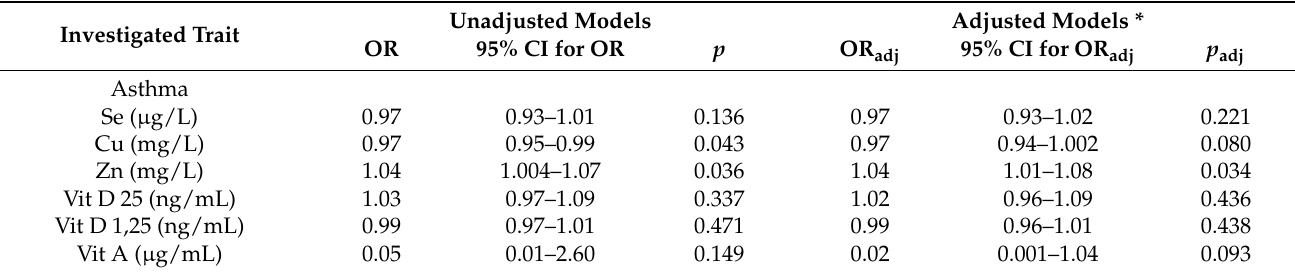
Table 3. Logistic regression for occurrence of asthma, Allergic rhinitis, Atopic dermatitis, food allergy and HDM